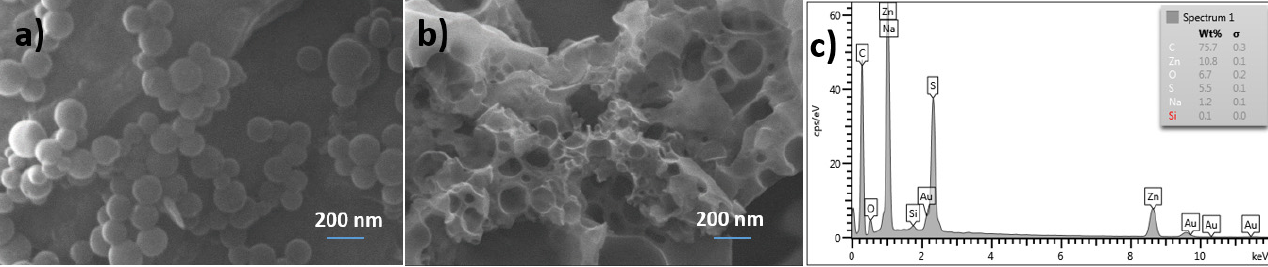
Figure 4. SEM micrographs of ( a ) PS- b -PMMA-SP and ( b ) PS- b -PMMA-SP composite with ZnS NPs and ( c ) EDX analysis of the composite